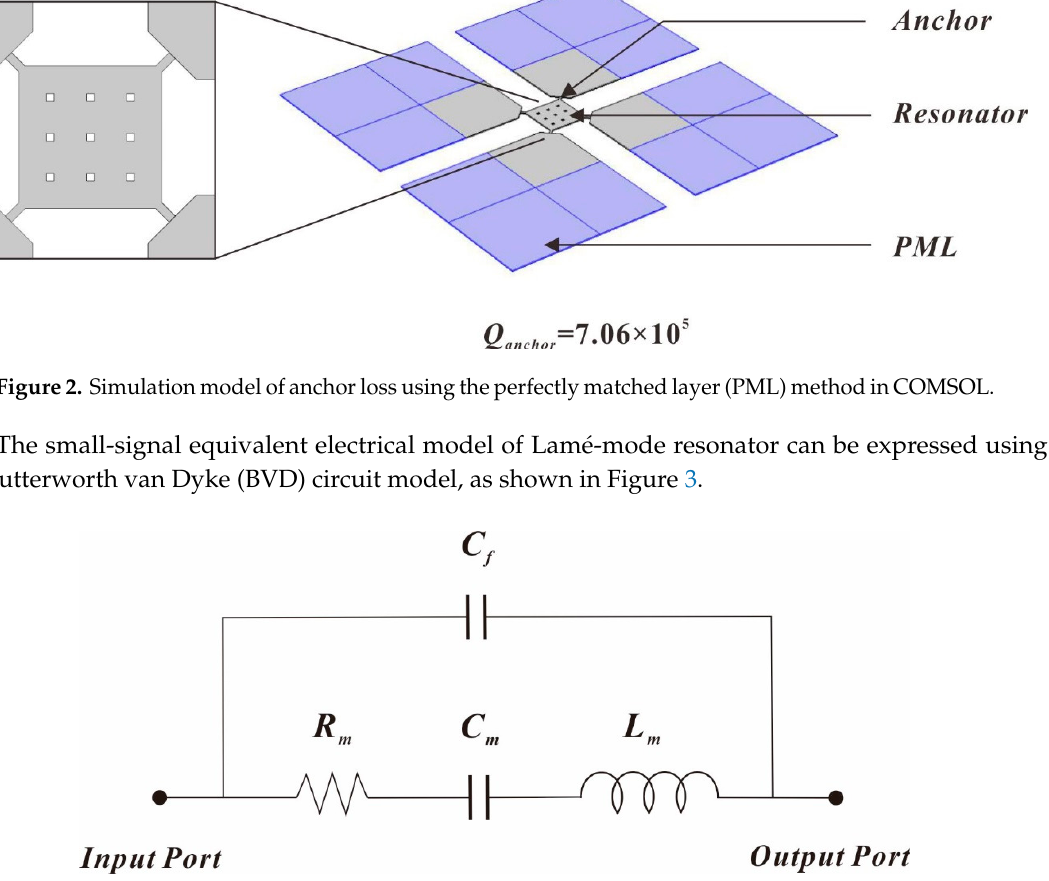
Figure 3. Small-signal equivalent electrical model of the Lamé-mode resonator.